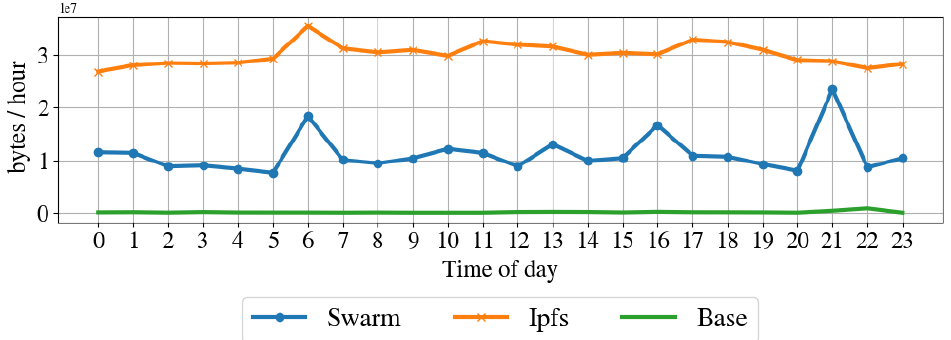
Figure 13. Network average transmitted bytes per hour before and while running the proposed architecture with IPFS and